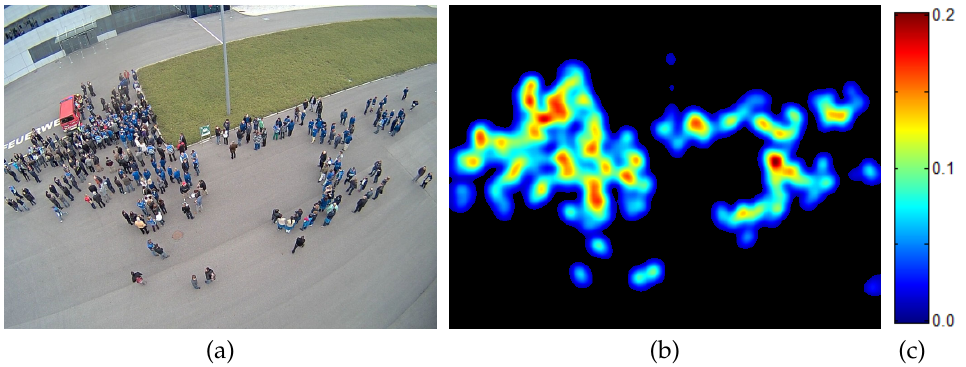
Figure 1. Person counting via density estimation. ( a ) Input image, ( b ) estimated density, and ( c ) colorbar that defines the color mapping to the fractional human count. For this example the true human count equals 303, while the given density predicts 294. Example adapted from our paper [8].